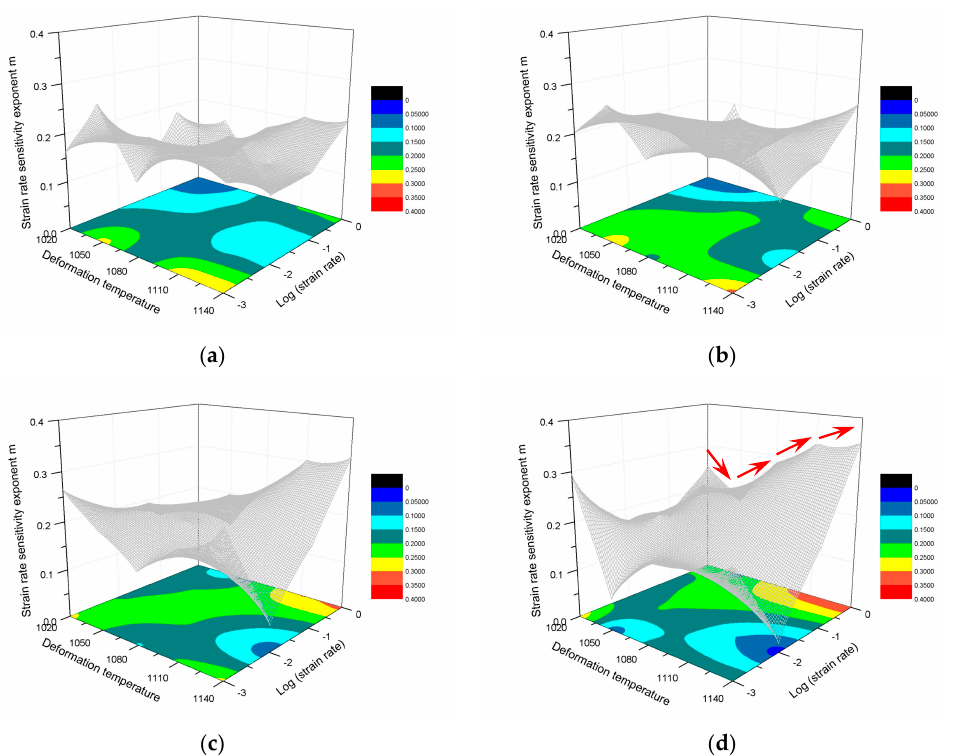
Figure 10. The response 3D surfaces of m -values for the PM/Wrought dual superalloy to deformation temperature and strain rate as true strains: ( a ) 0.1; ( b ) 0.3; ( c ) 0.5; ( d ) 0.69.